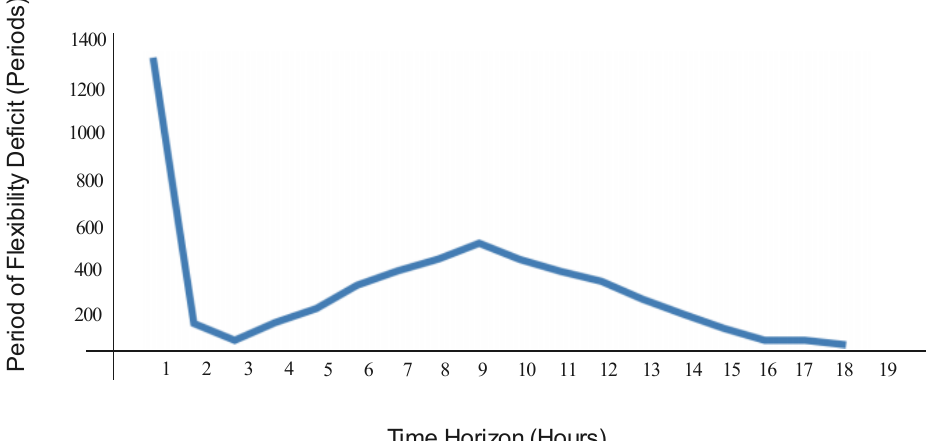
Figure 5. Number of PFD for different time horizons.